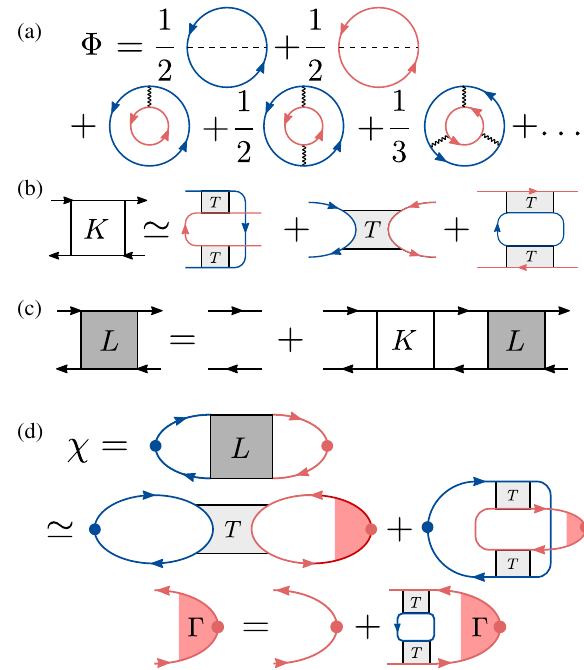
FIG. 5. Linear response theory for polaron drag within the conserving approximation to lowest order in polaron density. (a) The functional Φ . Dashed (wavy) lines represent disorder (interactions). Blue (dark gray) lines indicate dressed electron propagators, and red (light gray) lines indicate dressed exciton propagators as defined in Fig. 3. (b) The irreducible two-particle vertex K ¼ δ 2 Φ = δ G 2 . Only diagrams to leading order in exciton density are retained. (c) The Bethe-Salpeter equation (37) for the reducible two-particle vertex L . (d) The transconductivity dia- gram obtained from Eq. (39). The second and third lines show the solution for L based on the irreducible vertex K in panel